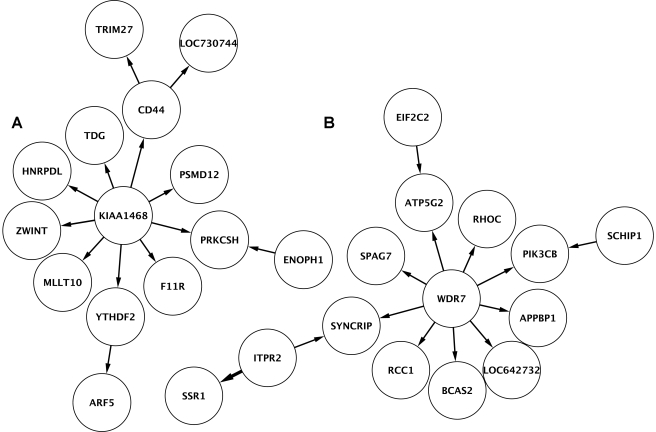
Directed subnetworks.Regulators are connected to their target genes based on results (p<0.05) from QTDT analyses. Directions of the arrows go from regulators to their target genes. The two examples correspond to genes connected to KIAA1468, a gene with no known function (a), and WDR7, a gene associated with age of onset of multiple sclerosis (b) [51].